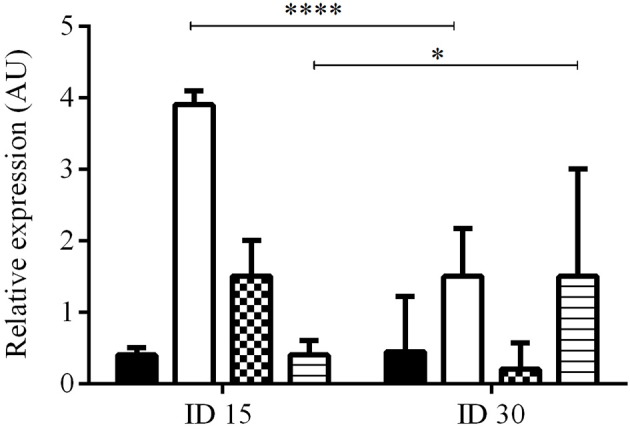
Relative expression of growth factors during infection and development of injury. The figure shows the relative expression at ID1 (n = 8) and ID30 (n = 8) vs. before infection (ID0) calculated by the ΔΔCT method. PDGF (black), EGF (white), FGF (pattern), and TGFβ1 (lines). ****p < 0.0001; *p < 0.0442.